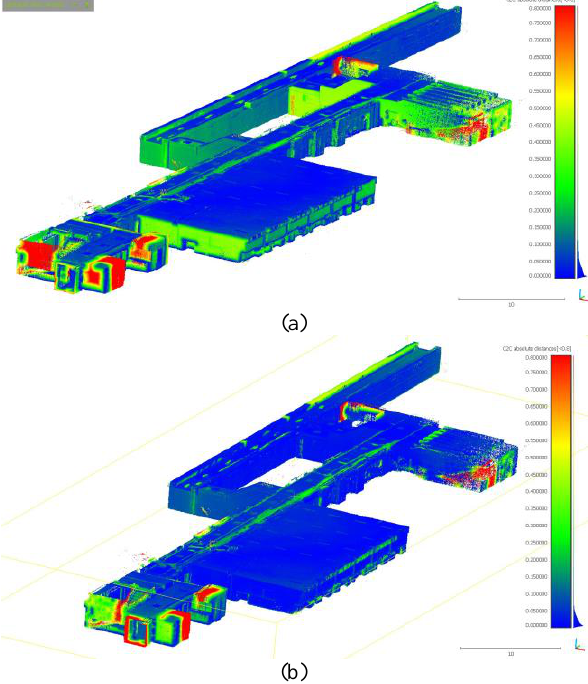
Figure 14. Aligned point clouds (a) scale distortion; (b) scale factor